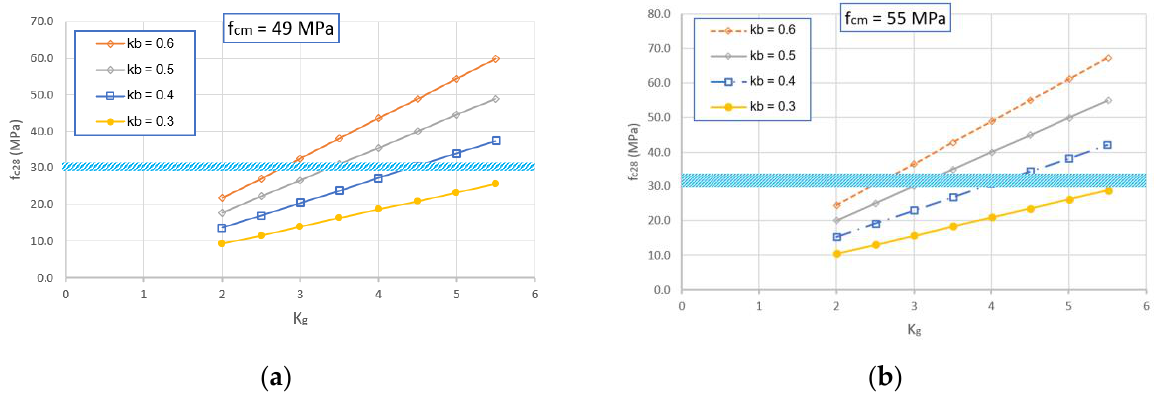
Figure 18. Numerical results of GRAC compressive strength at 28 days in function of K g and k b , for the case of ambient curing ( a ) and curing with heating treatment ( b ). The thick horizontal lines represent the experimental values.